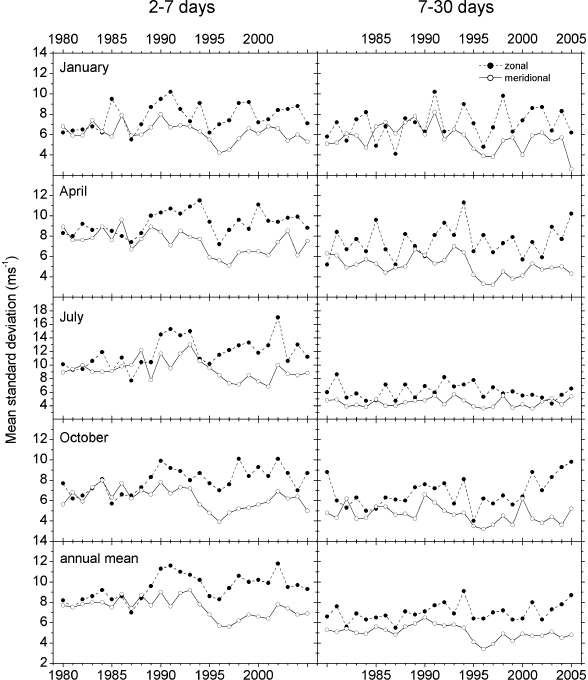
Fig. 4. Time series of zonal (solid symbols) and meridional (open symbols) wind standard deviation for four seasons (3-monthly means centred at the month indicated in the panels) and the annual mean, for the period bands 2–7 days (left panels) and 7–30 days (right panels). Note the different scaling of the ordinate for